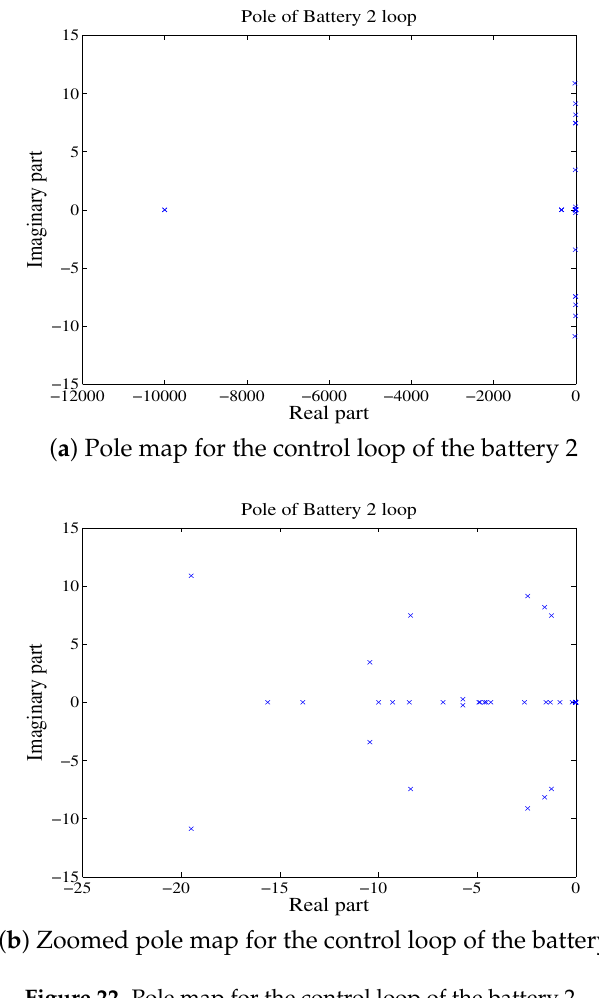
Figure 22. Pole map for the control loop of the battery 2.